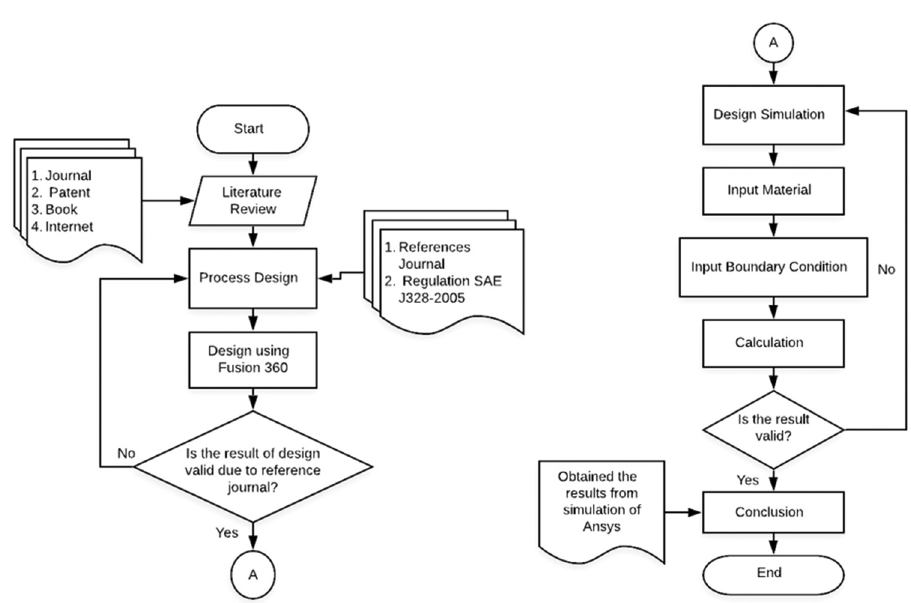
Figure 4: Research fl ow